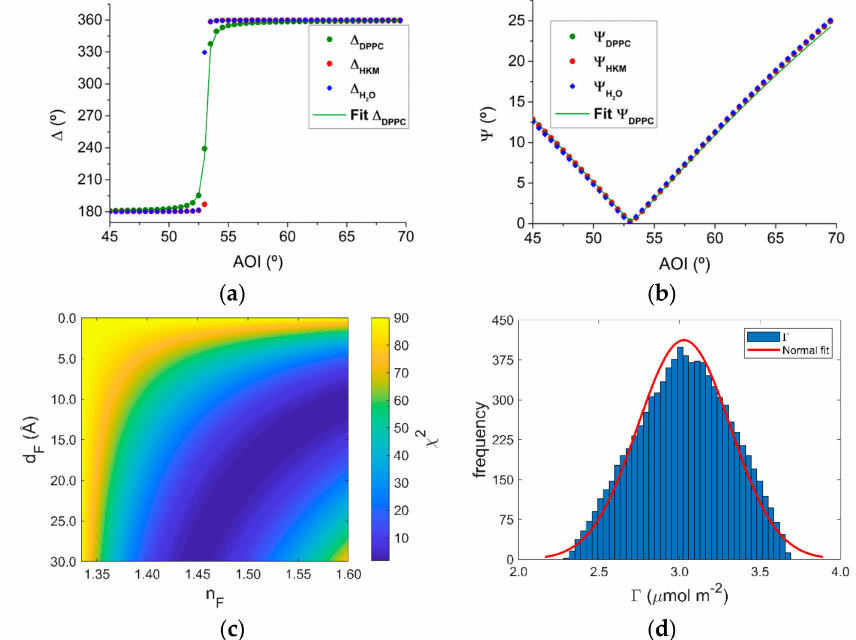
Figure 4. ( a ) ∆ and ( b ) Ψ vs. AOI of H 2 O (blue diamonds), HKM bu ff er (red circles), and DPPC (green circles). The green line corresponds to the ellipsometric angles values obtained from the fit that minimizes the χ 2 . ( c ) Colormap of the squared deviation χ 2 between measured and calculated ∆ and Ψ of a DPPC monolayer at the air / bu ff er interface at Π = 30 mN · m − 1 . Each pixel of the figure represents a value of χ 2 obtained from the fit of ∆ and Ψ vs. AOI using the correspondent values of d F and n F . ( d ) Normal distribution of Γ values correspondent to the region of lowest χ 2